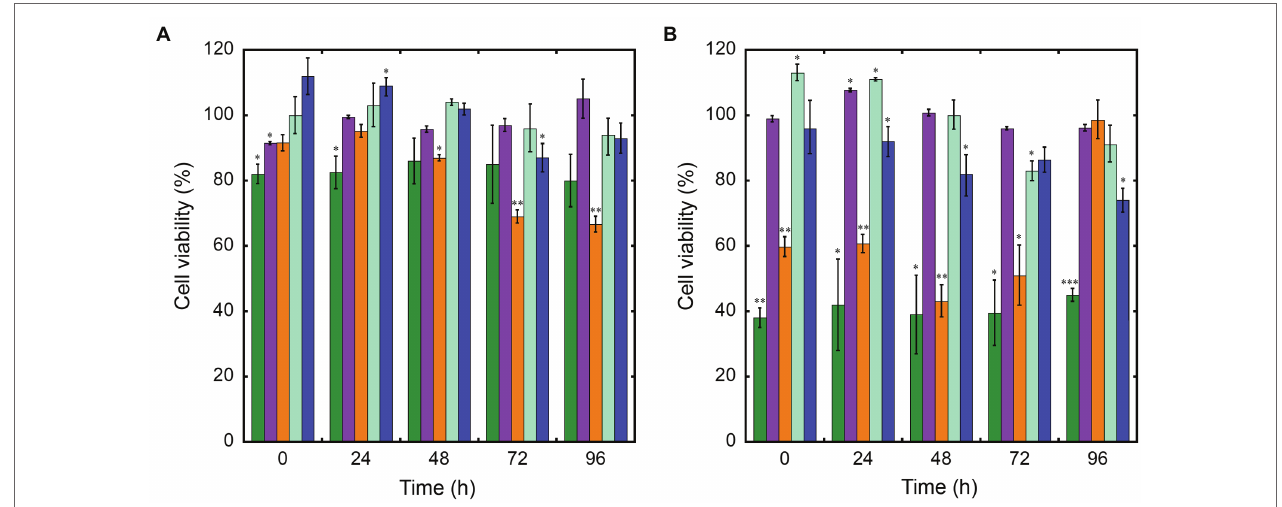
FIGURE 5 | Cell viability of SKOV-3 after exposure up to 96 h to IONPs (green bars), teicoplanin (violet), NP-TEICO (orange), vancomycin (turquoise), or NP-VANCO (blue). Cell viability was expressed as a percentage of viable cells compared to the untreated sample, set as 100%. The amount of nonconjugated or nanoconjugated GPA to be added was as follows: 0.9 μ g/ml (panel A ) and 9 μ g/ml (panel B ). In the case of nanoGPAs and IONPs, the amounts to be added were defined considering the antibiotic loaded on IONPs under the conditions described in Material and Methods. The values are expressed as mean ± standard deviation of three independent experiments. One-way ANOVA analysis, * p < 0.05; ** p < 0.01; *** p <